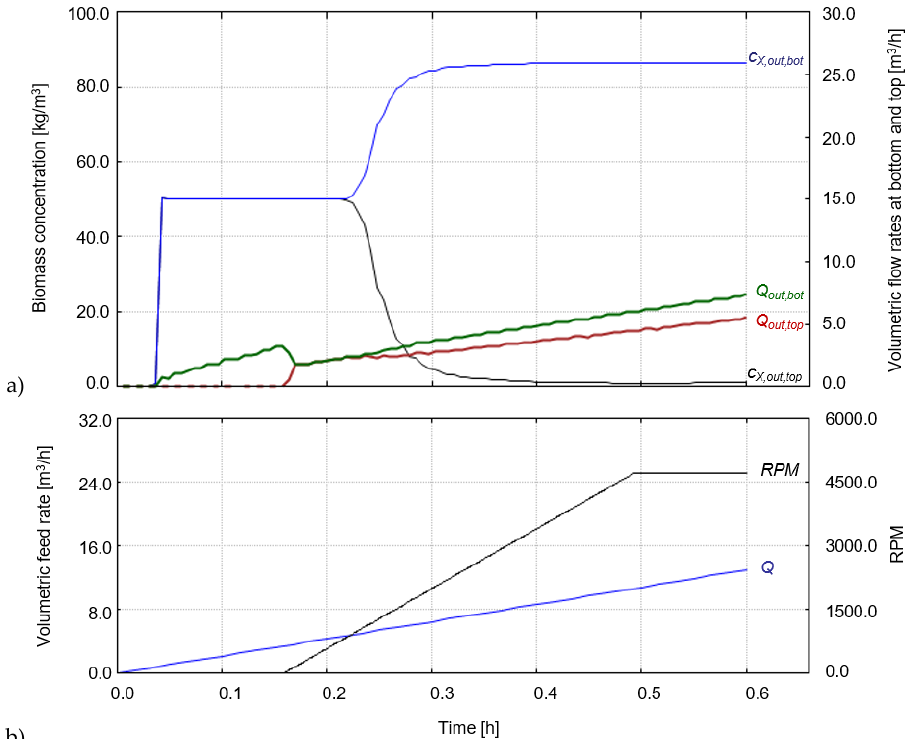
Figure 5. Centrifugation model simulation showing biomass concentration in outflows at the bottom ( c X,out,bot ) and at the top ( c X,out,top ) as well as volumetric flow rates out at the bottom ( Q out,bot ) and top ( Q out,top ) of the centrifuge (Figure 5a). Outflow starts when the maximum volume of the bowl is reached. Outflow at the top of the centrifuge ( Q out,bot ) starts at 50 rpm. The operator’s action is shown in Figure 5b with start of the feed to the centrifuges ( Q ) and the rotational speed ( RPM ). c X,out,bot increases with increasing RPM showing the dependence of separation efficiency on RPM and Q .